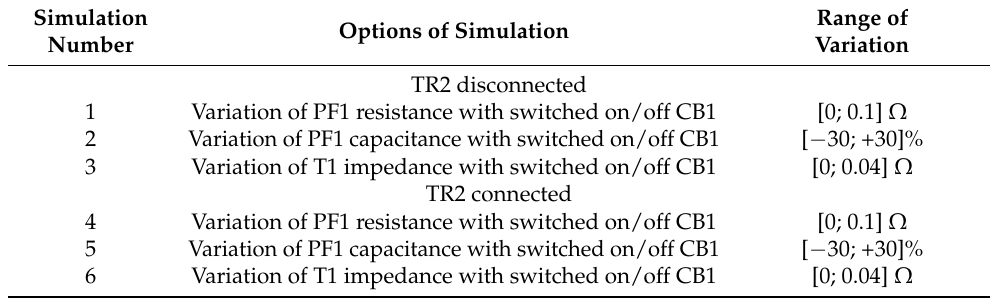
Table 2. Simulation parameters.